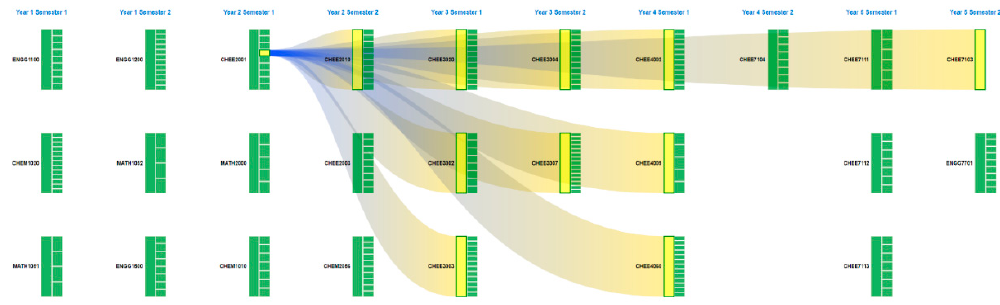
Figure 13. Tracking the linkages of a specific learning outcome through courses in the curriculum.